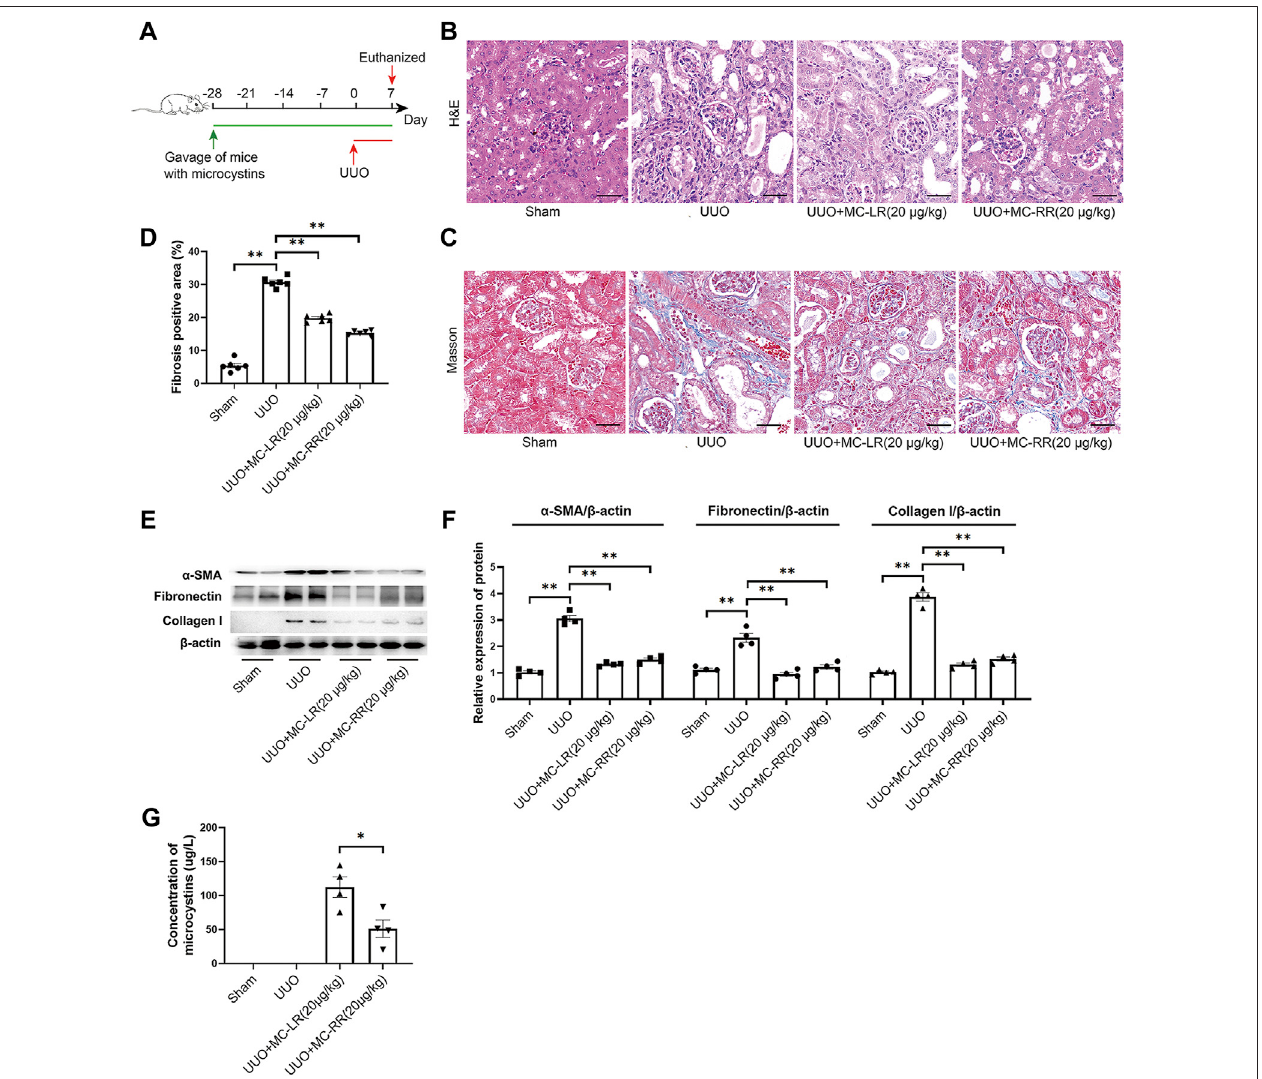
FIGURE 1 | Anti fi brotic effect of microcystin (MC) in renal fi brosis mice. Mice were treated with MC-LR (20 μ g/kg/day) or MC-RR (20 μ g/kg/day) by intragastrical administration for 4 weeks in advance, and then unilateral ureteral ligation was performed to construct a mouse model of obstructive renal fi brosis. The operated mice wereadministratedwithMC-LRorMC-RRforanotherweek,andthenwereeuthanizedforfurtheranalysis. (A) Schematicdiagramoftheexperimentaldesign.Fortymice weredividedintofourgroups, Sham,unilateralureteralobstruction(UUO),UUO +MC-LR,andUUO +MC-RRgroups, eachwith10mice.Nomicediedduring